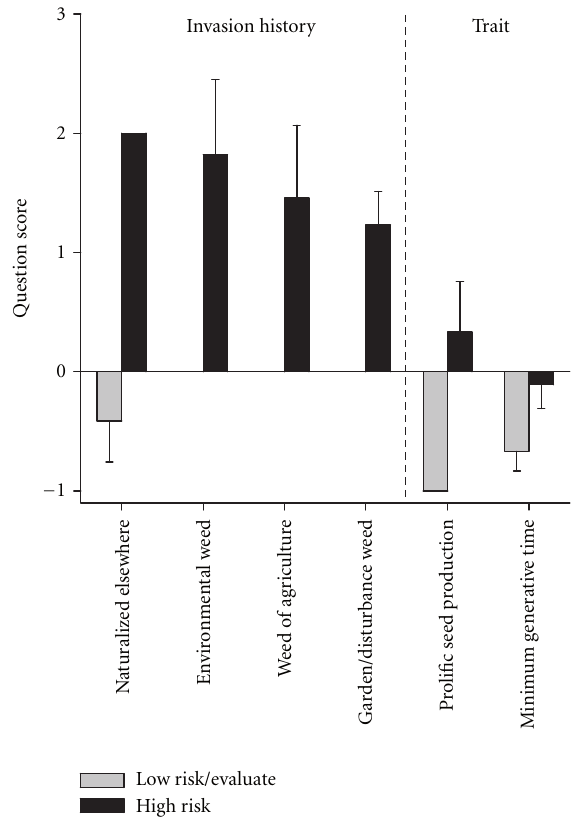
Figure 3: WRA questions on invasion history elsewhere or specific traits with responses (mean ± SE) that significantly ( P < 0 . 05) di ff erentiated taxa that scored ≤ 6 (low risk or requiring further evaluation) from > 6 (high